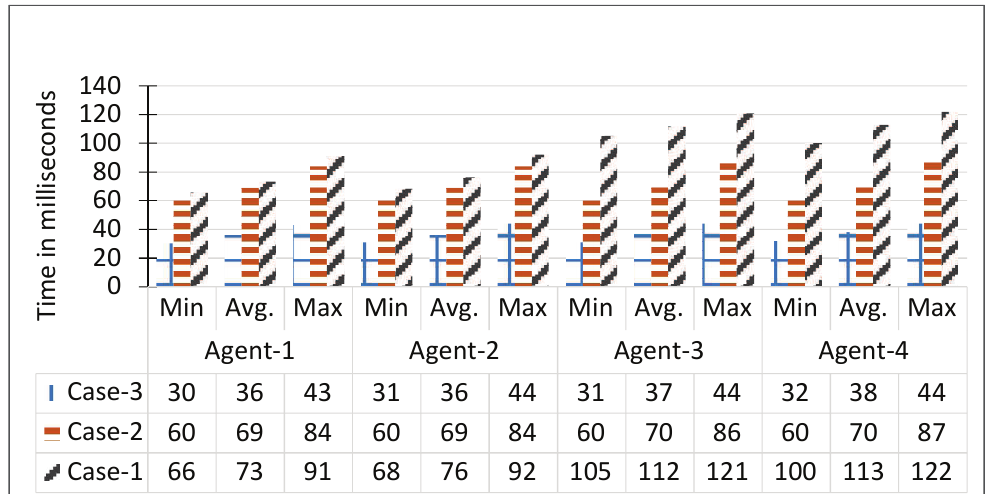
Figure 21. Notification delay performance evaluation.